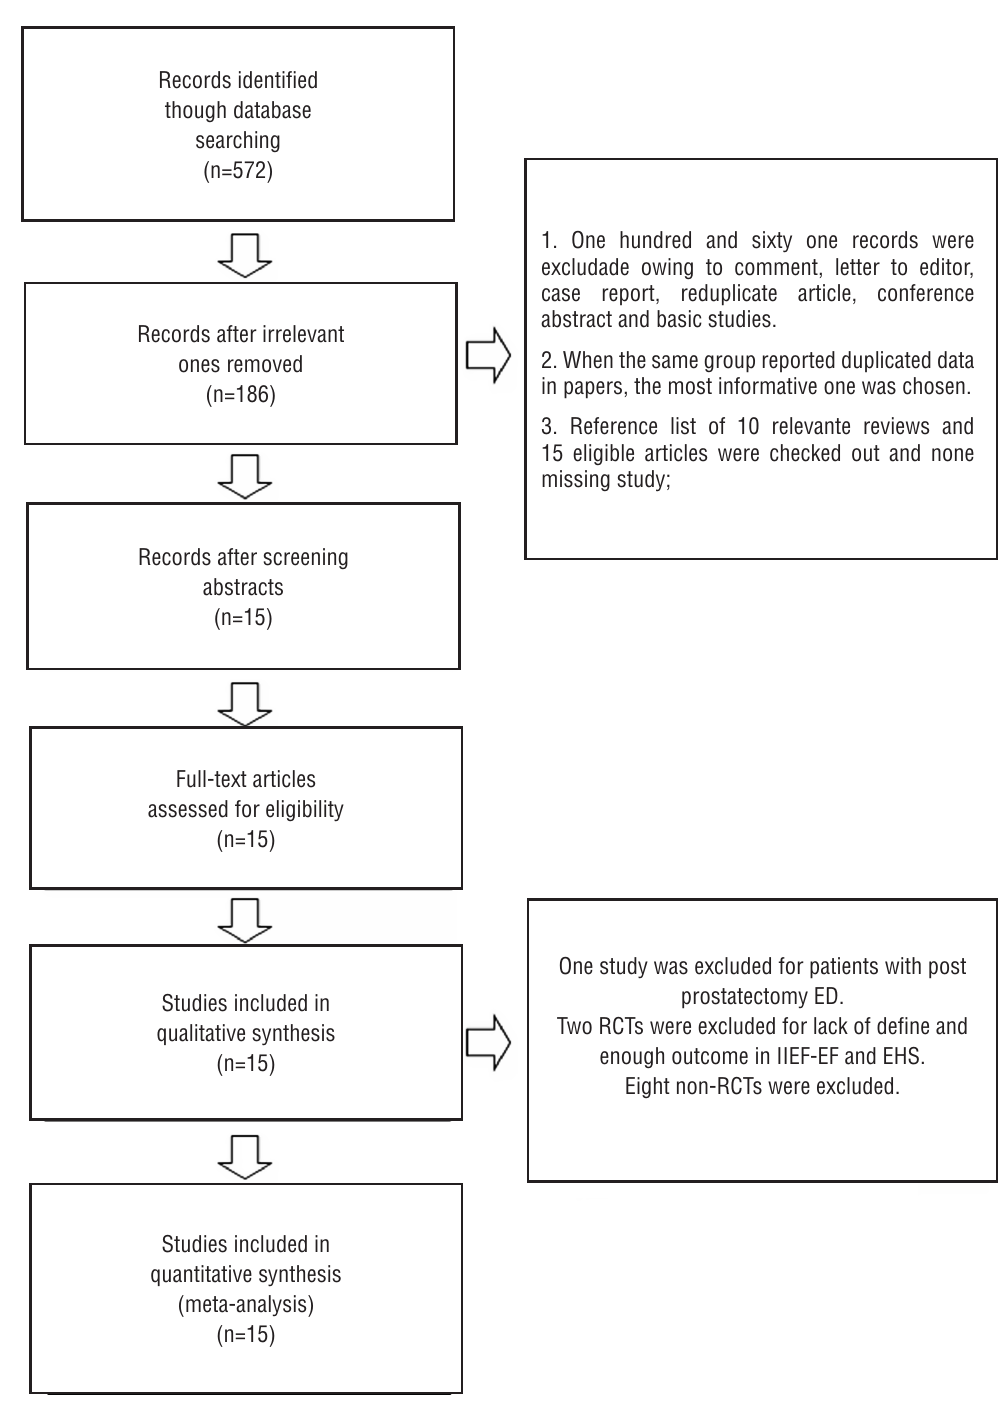
Figure 1 - Flow diagram outlining search results and final included and excluded